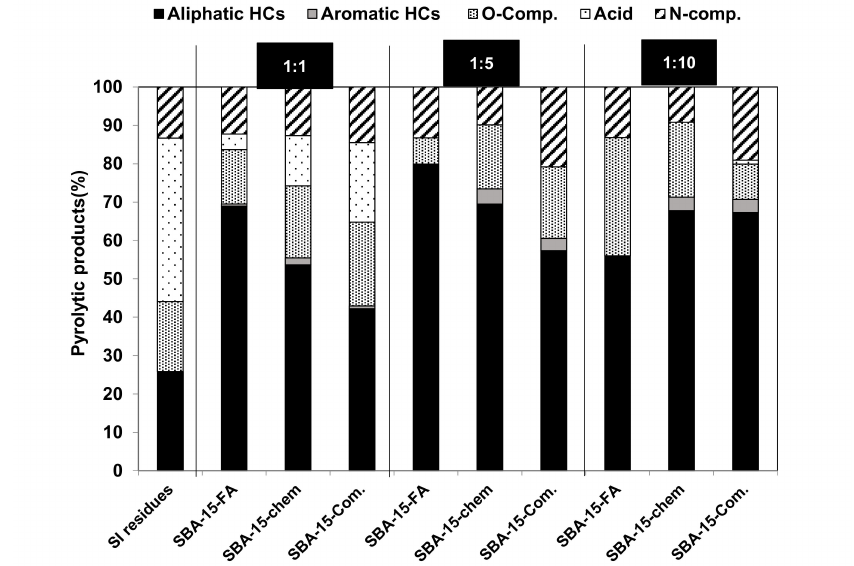
Figure 10. The pyrolytic products (% area) obtained from Py-GC / MS of Sacha inchi residues using SBA-15 catalysts synthesized from fly ash, chemical reagents, and commercials with SI / SBA-15 ratios of 1:0, 1:1, 1:5, and 1:10,